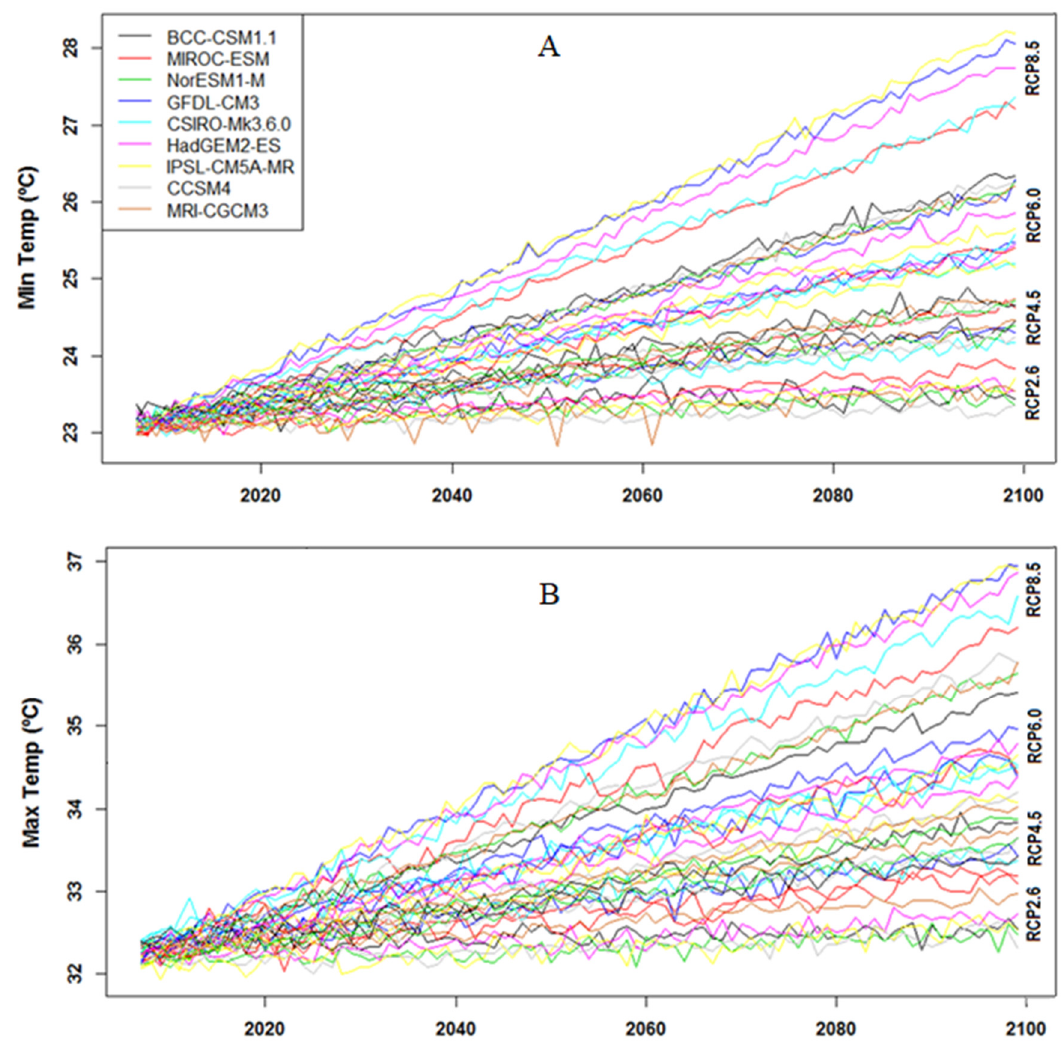
Figure 6 . Projection of annual daily average of ( A ) minimum and ( B ) maximum temperature in Alor Setar stations for RCP2.6, RCP4.5, RCP6.0 and RCP8.5.